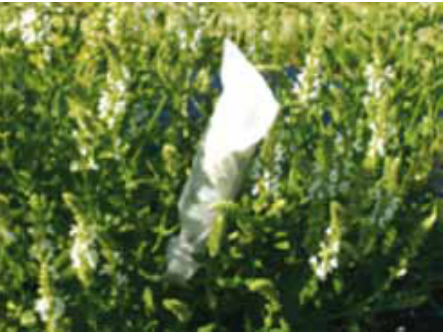
Figure 3: Series selection from high aesthetic value Salvia nemorosa shape- and colour versions